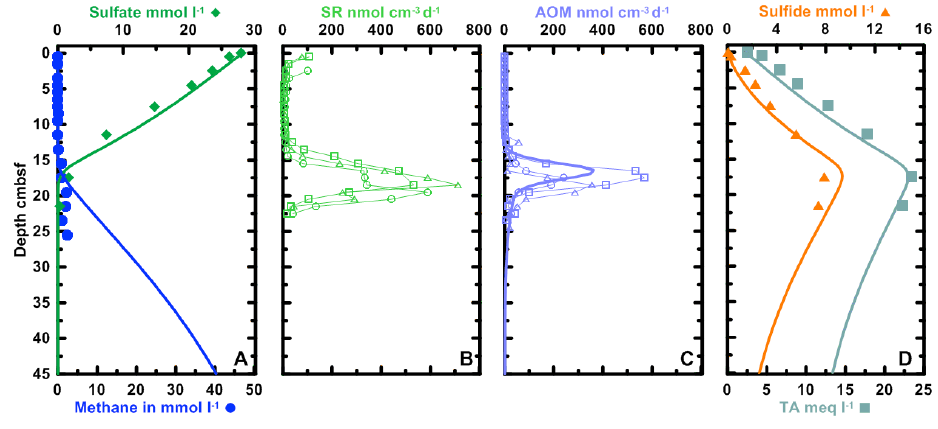
Figure 1. Depth profiles of measured and modeled porewater parameters and microbial turnover rates for SO206-29 (MUC), sampled from 402m water depth. (a) Measured (diamonds) and modeled (thick green line) sulfate concentrations (per Vol porewater), as well as measured (circles) and modeled (thick blue line) methane concentrations (per Vol sediment). (b) Three replicates (thin lines and symbols) of measured sulfate reduction rates (per Vol sediment). (c) Three replicates of measured (thin lines and symbols) and modeled (thick line) AOM rates (per Vol sediment). (d) Measured (triangles) and modeled sulfide concentration (thick orange line), as well as measured (squares) and modeled (thick grey line) total alkalinity (per Vol porewater).